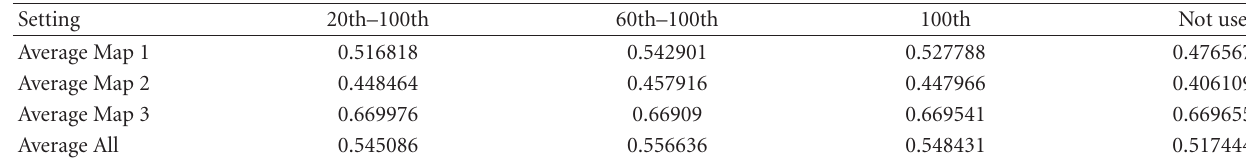
Table 1: Result of hill-climbing test.